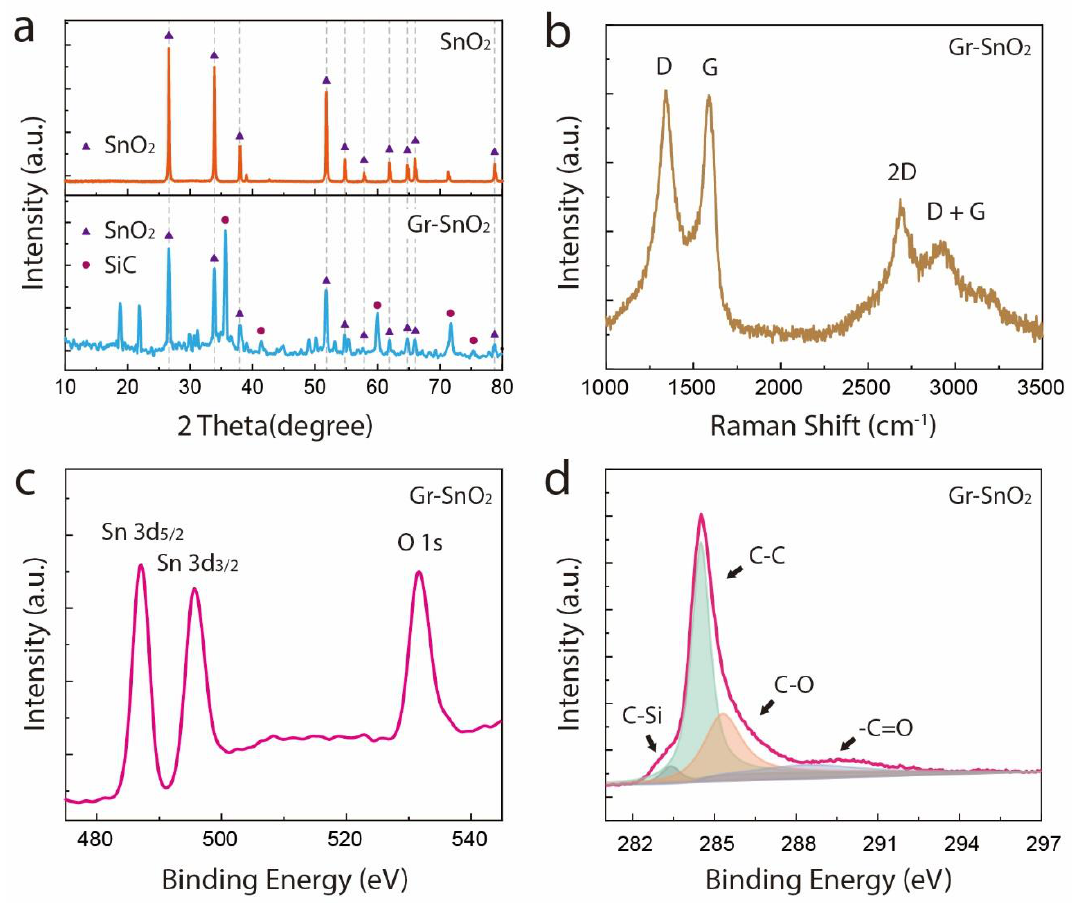
Figure 2. ( a ) The XRD patterns of the commercial SnO 2 particles and Gr-SnO 2 nanoparticles. ( b ) The Raman spectrum of the Gr-SnO 2 nanoparticles. ( c ) The high-resolution Sn 3 d 5/2 , Sn 3 d 3/2 , and O 1 s spectrum of the Gr-SnO 2 nanoparticles. ( d ) The high-resolution C 1 s spectrum of the Gr-SnO 2 nanoparticles.